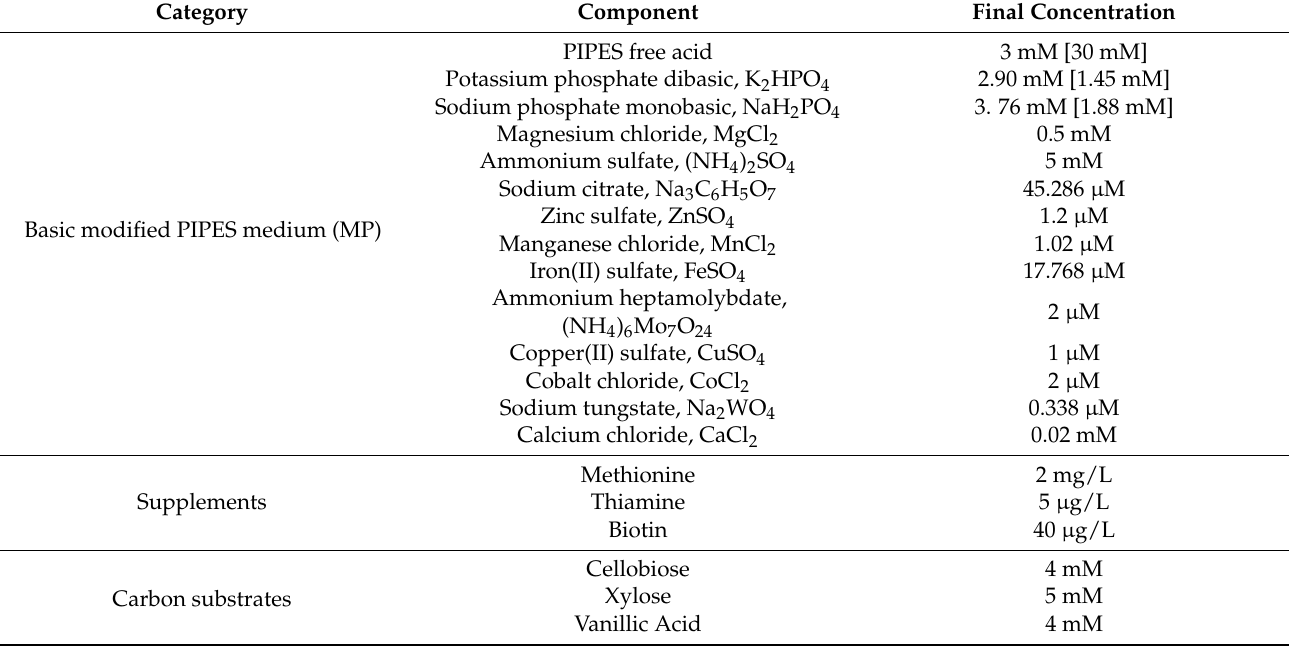
Table 1. Components of Model Lignocellulose medium. Basic MP medium is prepared as described in [26], with the exception that PIPES and P concentrations are altered in Model Lignocellulose: originally published concentrations for these compounds are given in square